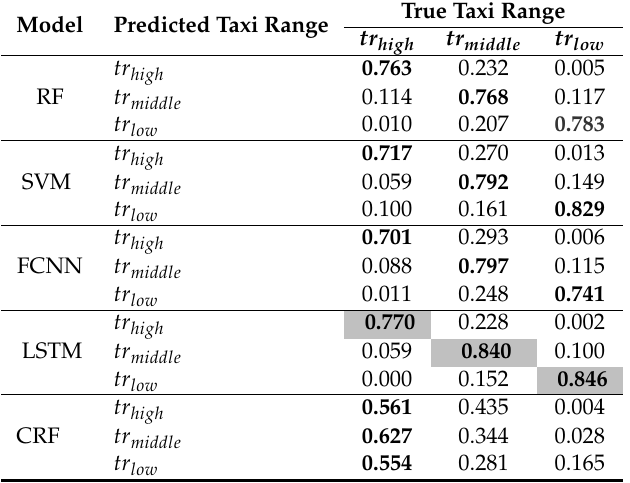
Table 4. Confusion matrix of the five models under study. The best rates per model are marked in bold. The grayed cells contain the highest rates per true